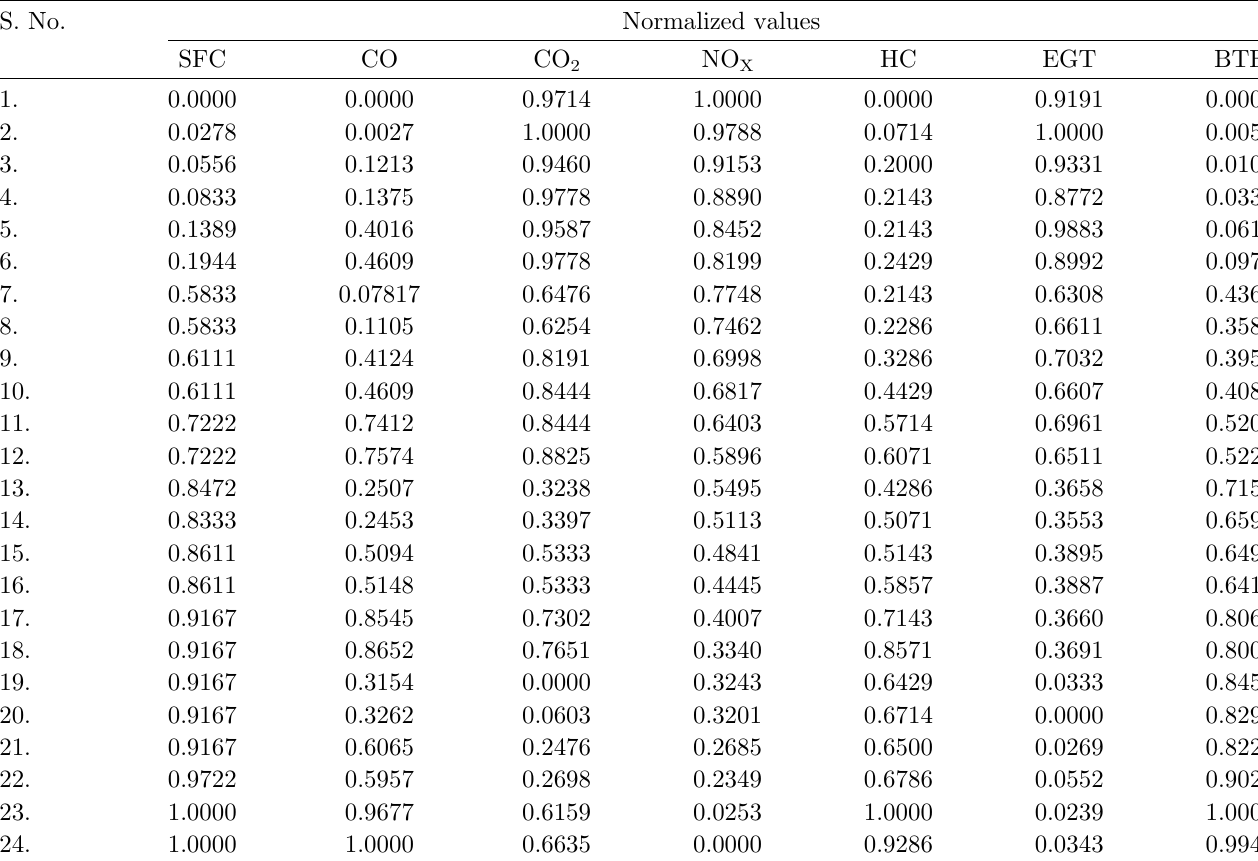
Table 4. Normalized values of the various performance characteristics of the oil blends. S.